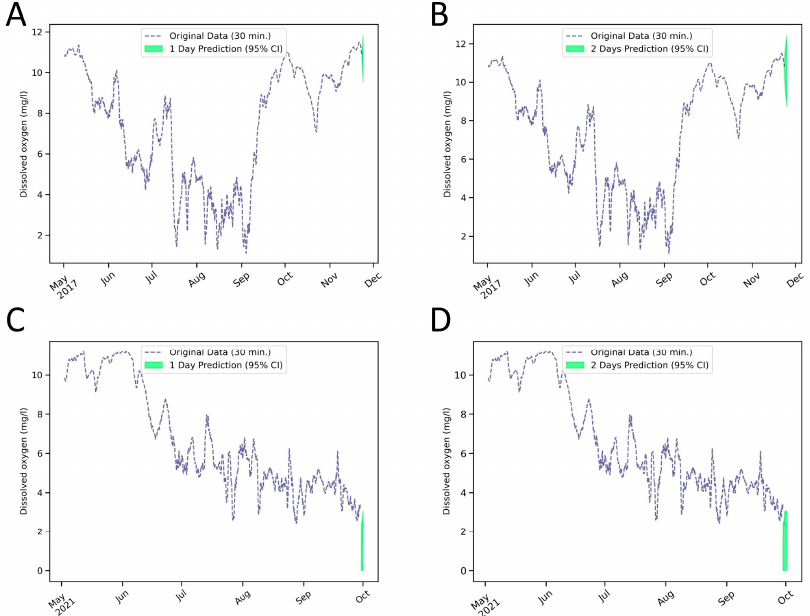
Figure 14. Prediction for future DO values based on an ARIMA model with 95% CI, shown as green range: ( A ) 1-day prediction based on the 2017 dataset; ( B ) 2-day prediction based on the 2017 dataset; ( C ) 1-day prediction based on the 2021 dataset; ( D ) 2-day prediction based on the 2021 dataset (some of the values predicted fell below 0 mg/L of DO, and for these values, a threshold was imposed at 0.00 mg/L).